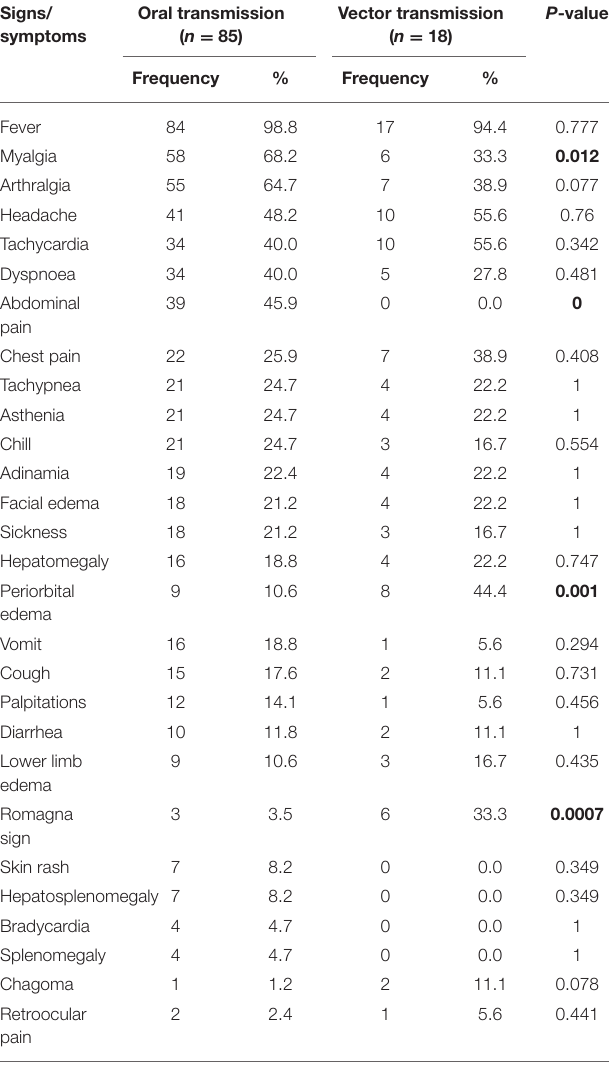
TABLE 1 | Frequency of acute CD signs/symptoms, according to transmission route, Casanare 2012–2020. Signs/ symptoms